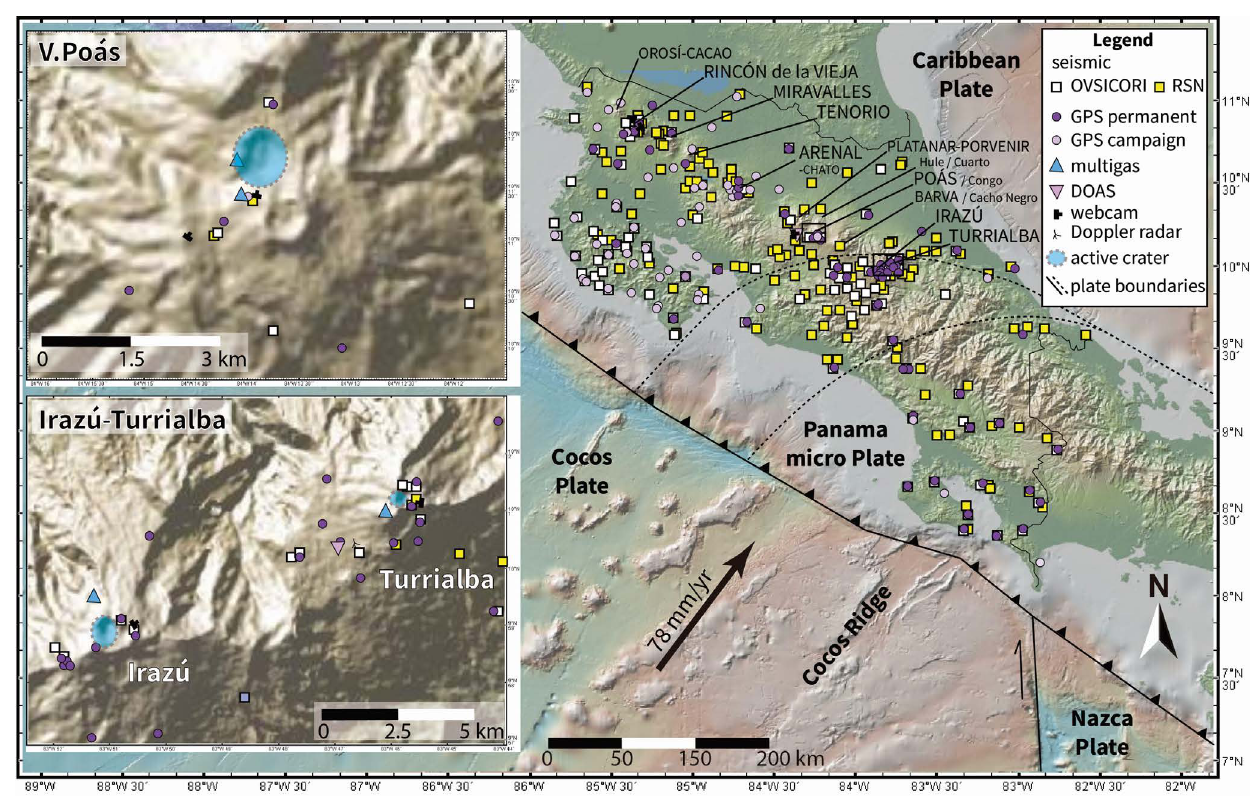
Figure 1: General map of Costa Rica showing the tectonic setting and the network managed by OVSICORI-UNA and RSN (UCR-ICE) in 2019 for both tectonic and volcanic surveillance. The network is detailed in Table 1. The maps on the left show details of the Poás and Irazú-Turrialba volcanic